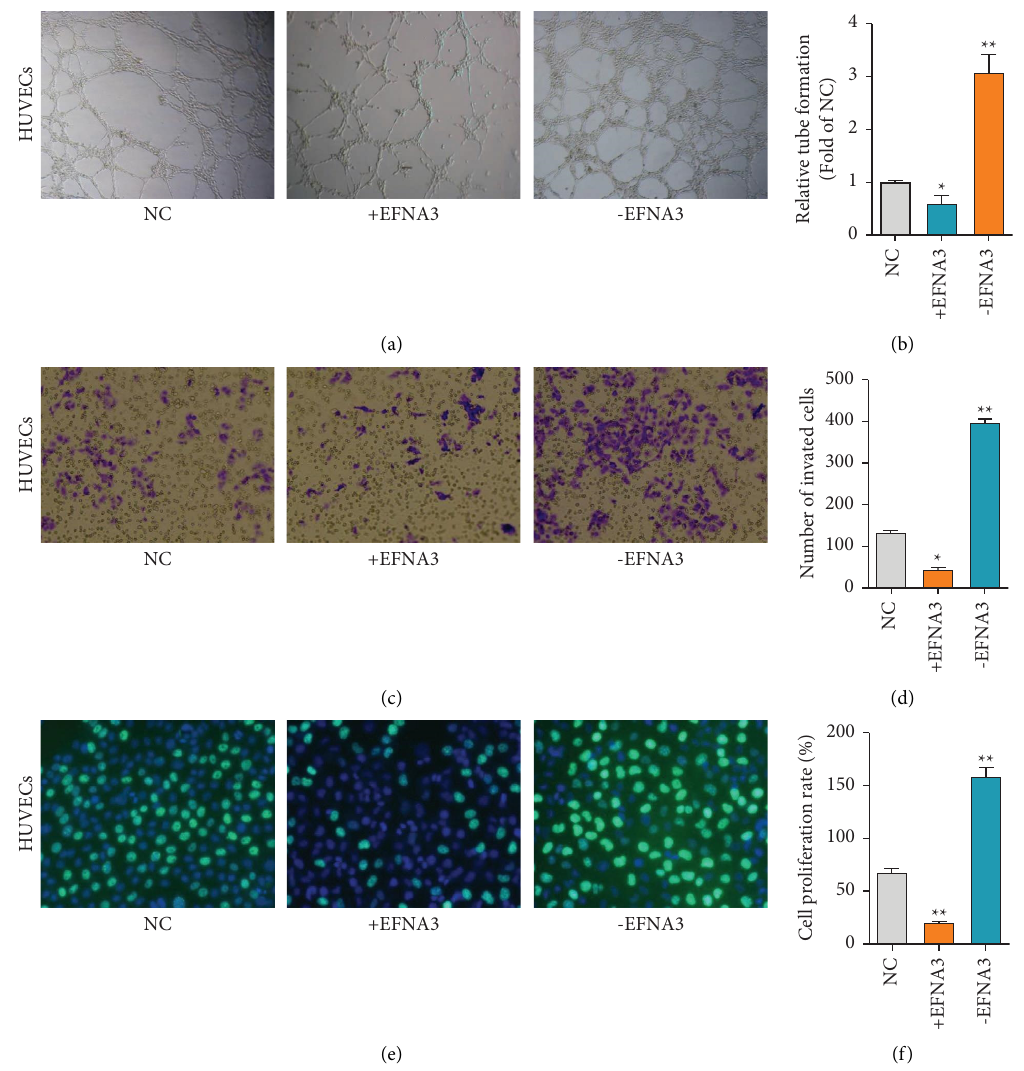
Figure 5: EFNA3 inhibited tumor angiogenesis, cell invasion, and proliferation in PDAC cells. (a–b) Te angiogenic abilities of the indicated treated HUVECs measured by tube formation assays. Magnifcation, × 200. (c–d) Te invasion abilities of HUVECs were measured by transwell assays. Magnifcation, × 200. (e–f) Te proliferation abilities of the indicated treated HUVECs were measured by EdU assays. Magnifcation, ×